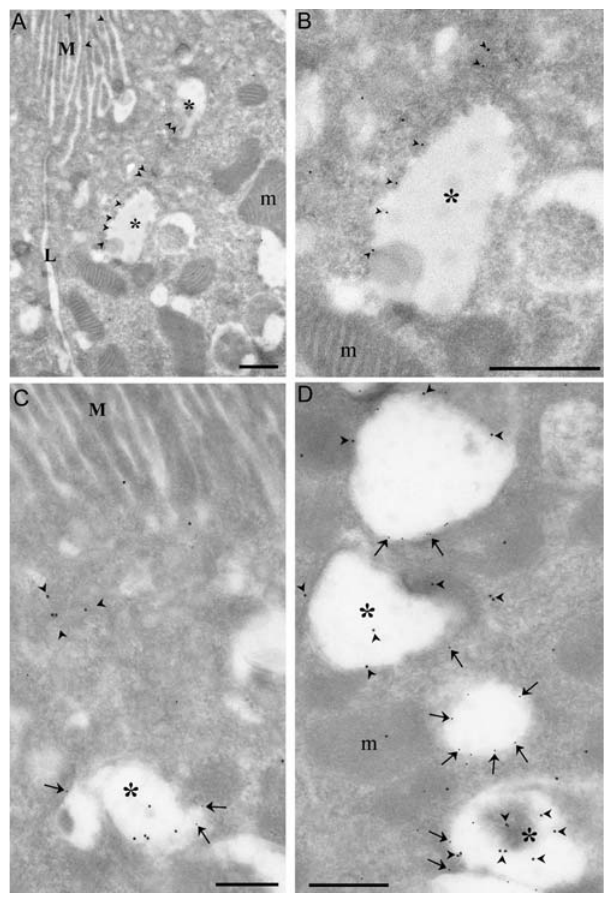
Figure 9. Immunolocalisation of Rabankyrin-5 in the Mouse Kidney Mouse kidney cortex was processed for frozen section immunoelec- tron microscopy. Sections were (A and B) single labelled for Rabankyrin-5 (arrowheads, 10 nm) or (C and D) double labelled (arrows, 5 nm) for Rabankyrin-5 and LAMP-1. (A) Low-magnification view of the apical region of two proximal tubule cells demonstrates low labelling for Rabankyrin-5 on apical microvilli (M) but stronger labelling (arrowheads) of large subapical electron-lucent vesicular structures (asterisks). One of these struc- tures is shown at higher magnification in (B). L, lateral membrane. (C) Rabankyrin-5 labels LAMP-1–negative subapical structures as well as compartments showing low LAMP-1 labelling (arrows and asterisk). (D) Rabankyrin-5 (arrowheads) associates with compartments, which show no or weak labelling for LAMP-1 (asterisks). In addition, low Rabankyrin-5 labelling is associated with more strongly labelled LAMP-1–positive compartments. Note that there is some nonspecific labelling of mitochondria (m). Scale bars represent 500 nm. DOI: 10.1371/journal.pbio.0020261.g009